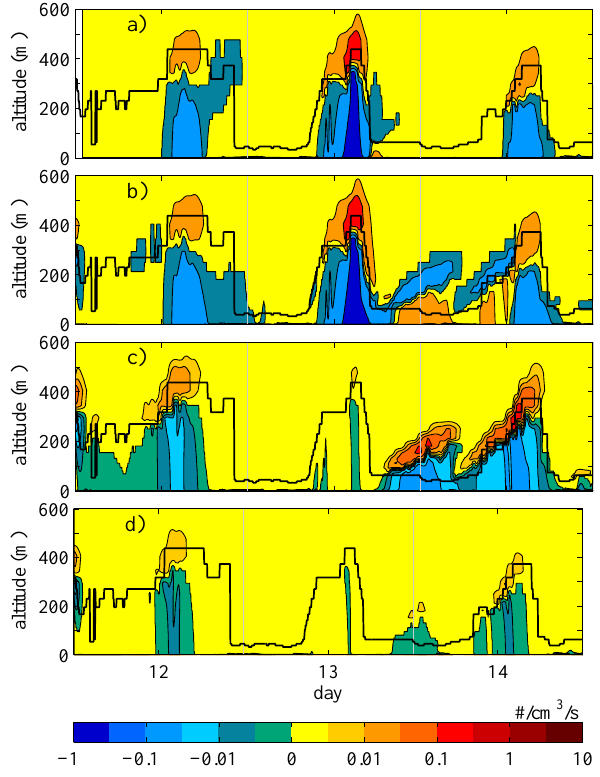
Fig. 7. Median collection rate of (a) 3–6nm (b) 3–25nm, (c) 25– 100nm and (d) 100–1000nm particles. Collection rate is calculated as given by Eq. (3). The height of canopy is